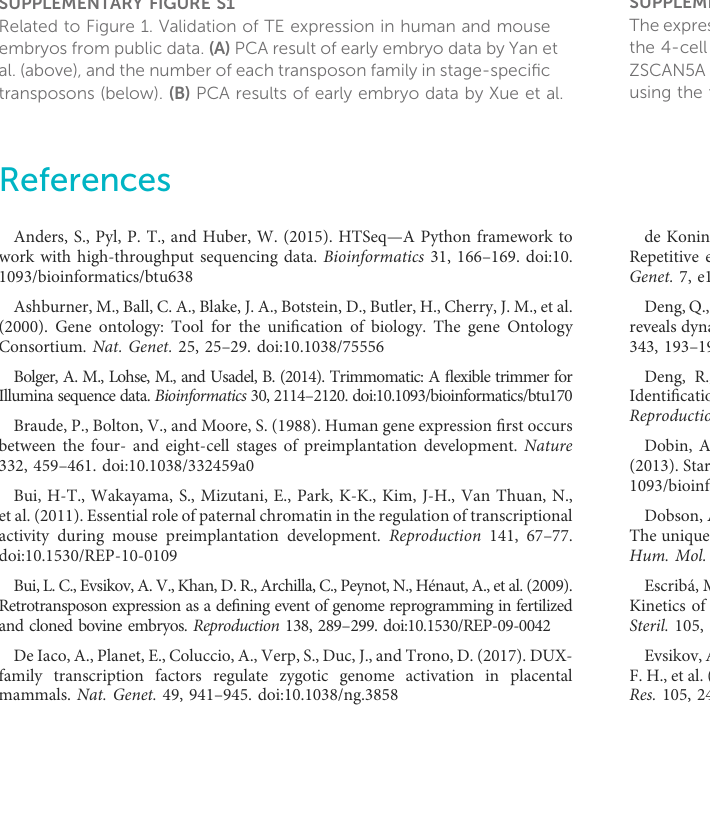
SUPPLEMENTARY FIGURE S1 Related to Figure 1. Validation of TE expression in human and mouse embryos from public data. (A) PCA result of early embryo data by Yan et al. (above), and the number of each transposon family in stage-speci fi c transposons (below). (B) PCA results of early embryo data by Xue et al.